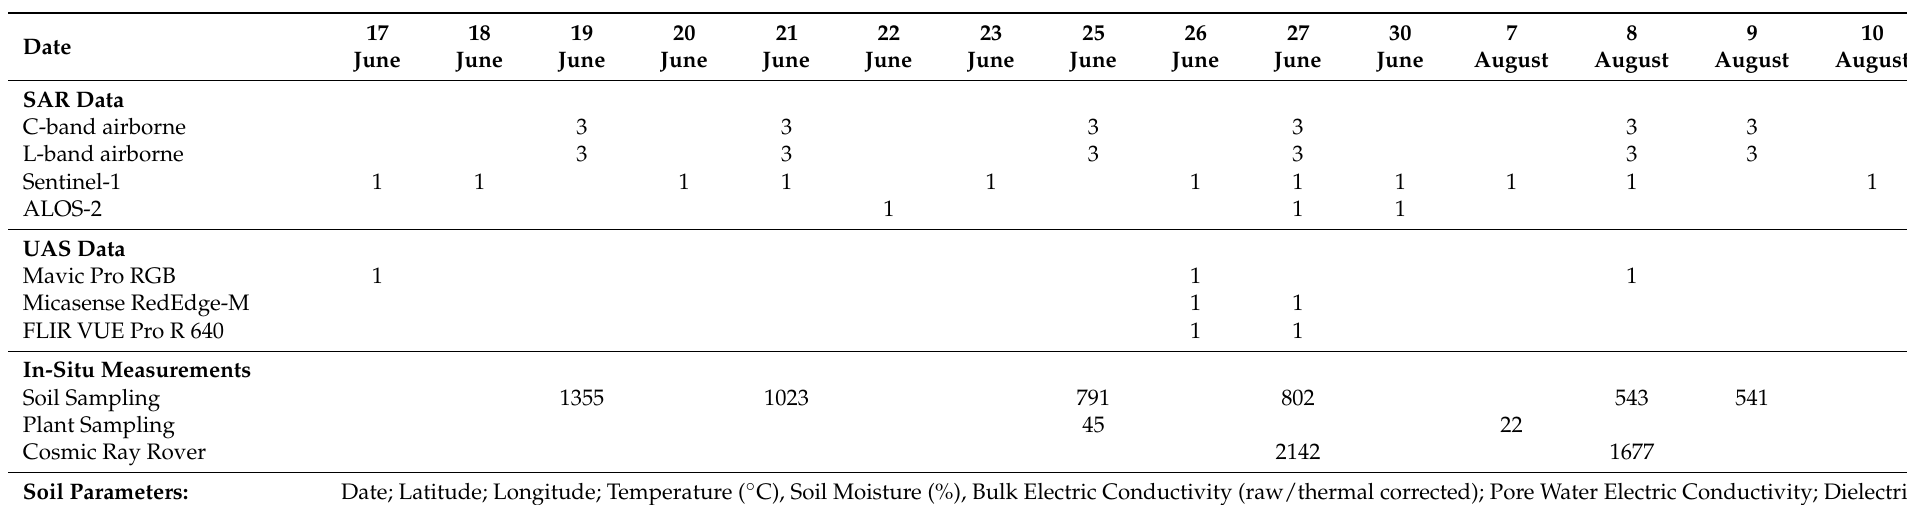
Table 1. Number of SARSense data acquisitions for the period between 17–30 June and 8–10 August